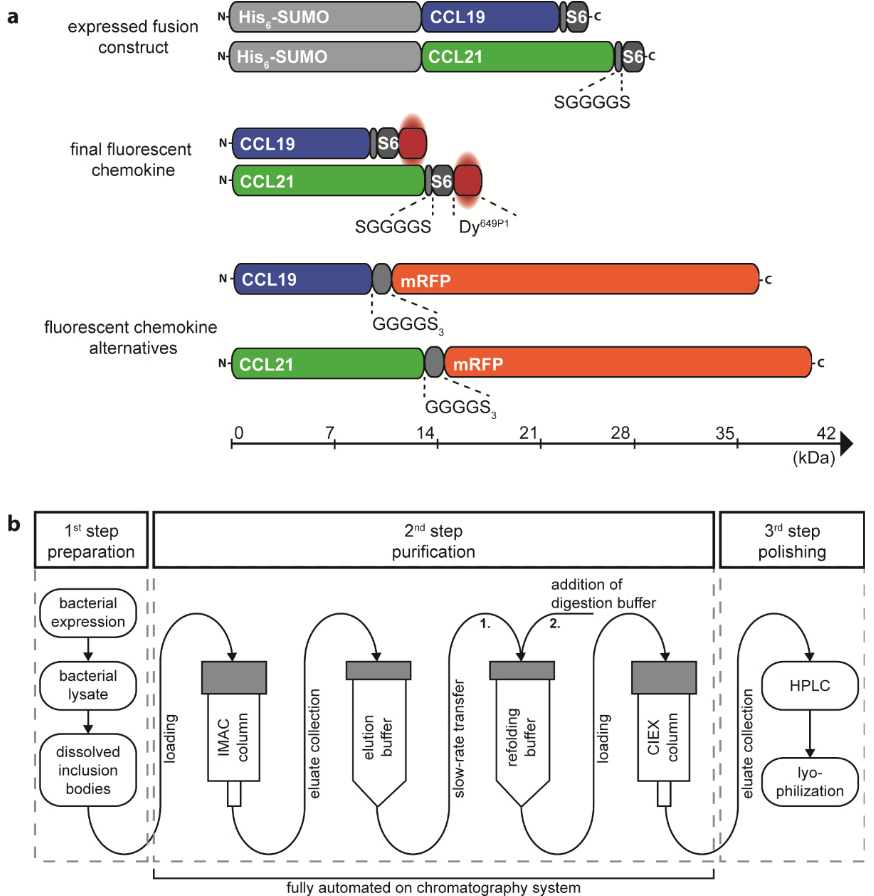
Figure 1. Design and production of the recombinant chemokines CCL19 and CCL21. ( a ) Schematic representation of the size matched expression constructs and the corresponding final fluorescently labeled chemokine proteins. A cleavable His 6 -SUMO-tag is fused to the N-terminus of mature human CCL19 and CCL21 followed by a short, flexible linker and the S6-tag for enzymatic labelling with the dye Dy 649P1 . Human CCL19-mRFP and CCL21-mRFP are included for size comparison. ( b ) Workflow overview of the chemokine production process. IMAC purification, chemokine refolding, and CIEX purification can be performed in an automated fashion on a chromatography system. Freshly prepared or reconstituted, recombinant human CCL19-S6 and CCL21-S6 were site-specific fluorescently labeled using the phosphopantetheinyl-transferase Sfp, which transfers the fluorescent dye (here Dy 649P1 ) conjugated phosphopantetheine moiety of CoA to the first serine residue of the S6-tag. An additional reverse-phase HPLC purification step served to separate the fluorescently labeled CCL19-S6 649P1 or CCL21-S6 649P1 , respectively, from residual substrate bound to the Sfp transferase (marked with asterisks in Figure 2c,d). Figure 2c,d illustrate the high efficiency of chemokine labeling using this strategy. SDS- PAGE followed by Coomassie-staining or Western blotting revealed the correct size of the recombinant chemokine variants (Figure 2e,f) that match the calculated molecular weights of native CCL19 (8.80 kDa), CCL19-S6 (10.50 kDa), CCL19-S6 649P1 (12.58 kDa), as well as of native CCL21 (12.25 kDa), CCL21-S6 (13.95 kDa), and CCL21-S6 649P1 (16.03